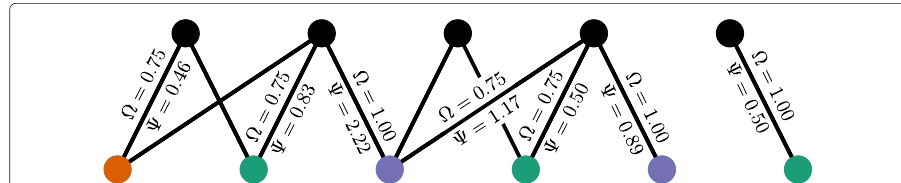
Fig. 5 Schematic illustrating the difference between effective resistance (cid:4) and contraction importance (cid:5) in a gendered bipartite authorship network. This example network has the basic structure of the bipartite authorship network we studied: a collection of publications (represented by the black nodes) connected to their authors (represented by the nodes with colors corresponding to their assigned gender labels: “ women ”, “ men ” and “ unknown ”). Both effective resistance and contraction importance quantify